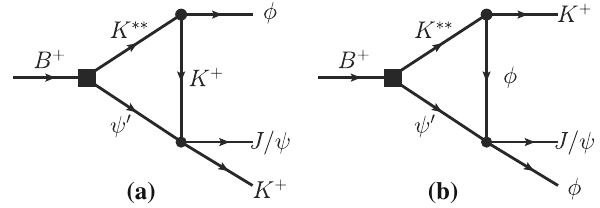
Fig. 4 B + → J /ψφ K + decay via the a K ∗∗ ψ (cid:4) K and b K ∗∗ ψ (cid:4) φ rescatteringdiagrams.Kinematicconventionsfortheintermediatestates are a ψ (cid:4) ( q 1 ) , K ∗∗ ( q 2 ) , K + ( q 3 ) and b ψ (cid:4) ( q 1 ) , K ∗∗ ( q 2 ) , φ( q 3 )